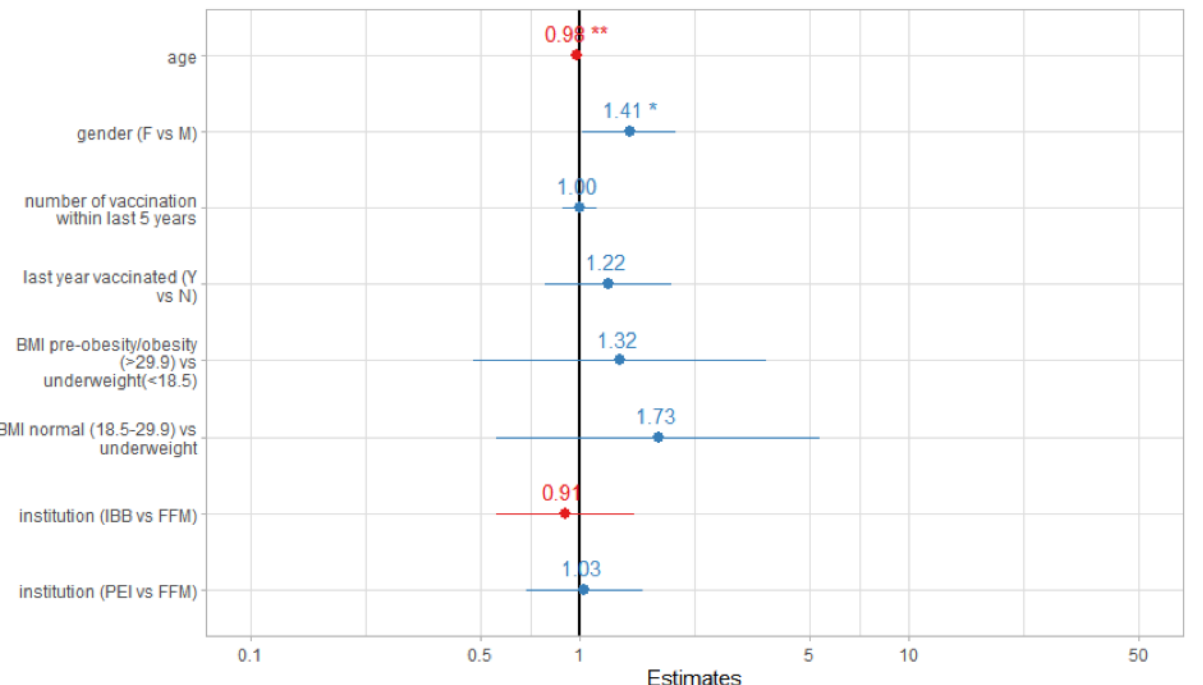
Figure 6. Factors associated with adverse event following immunization occurrence versus nonoccurrence. F: female; M; male; Y: yes; N: no;